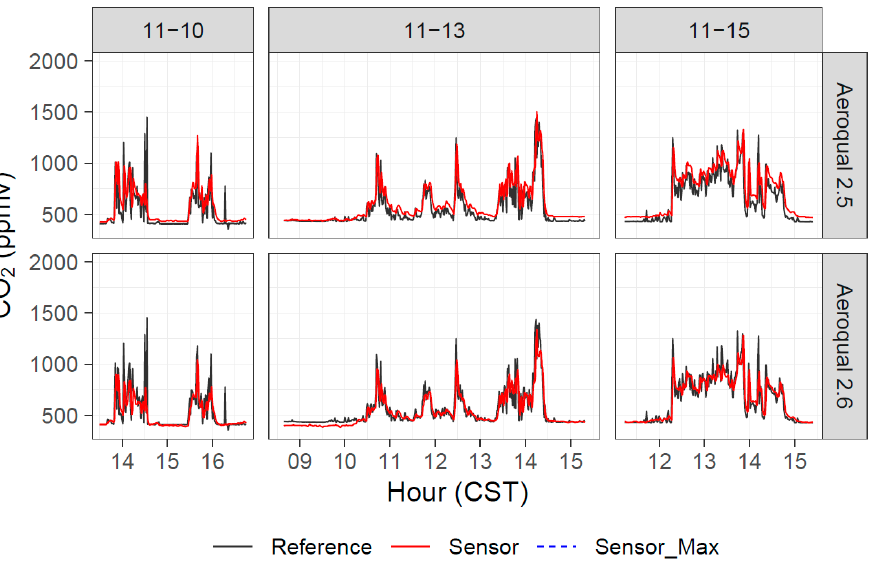
Figure 9. Timeseries of reference and Aeroqual CO 2 measurements during three days of Tallgrass Prairie prescribed burn experiments in 2017 when we had CO 2 sensors present.